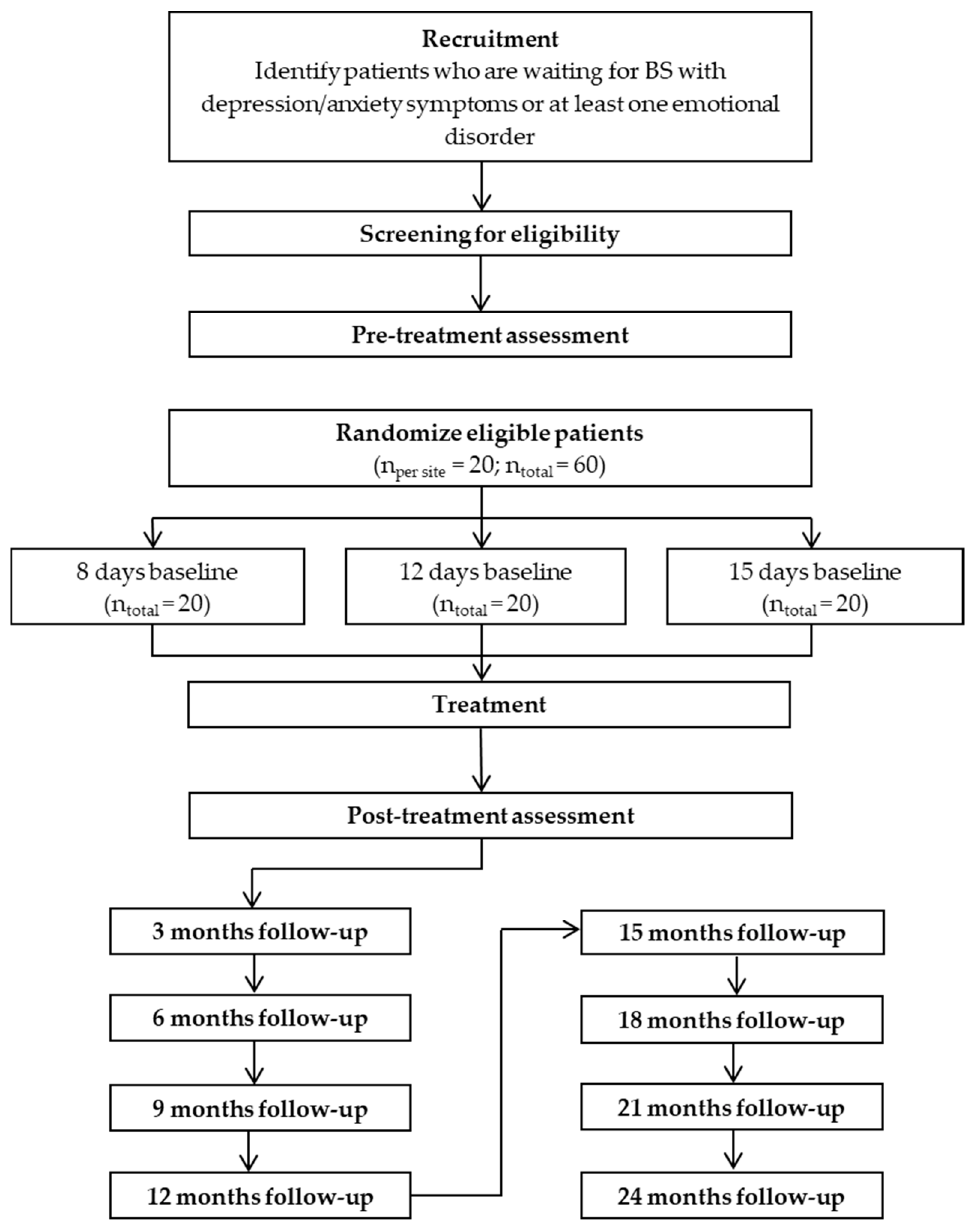
Figure 1. Study flow chart. BS: Bariatric surgery.